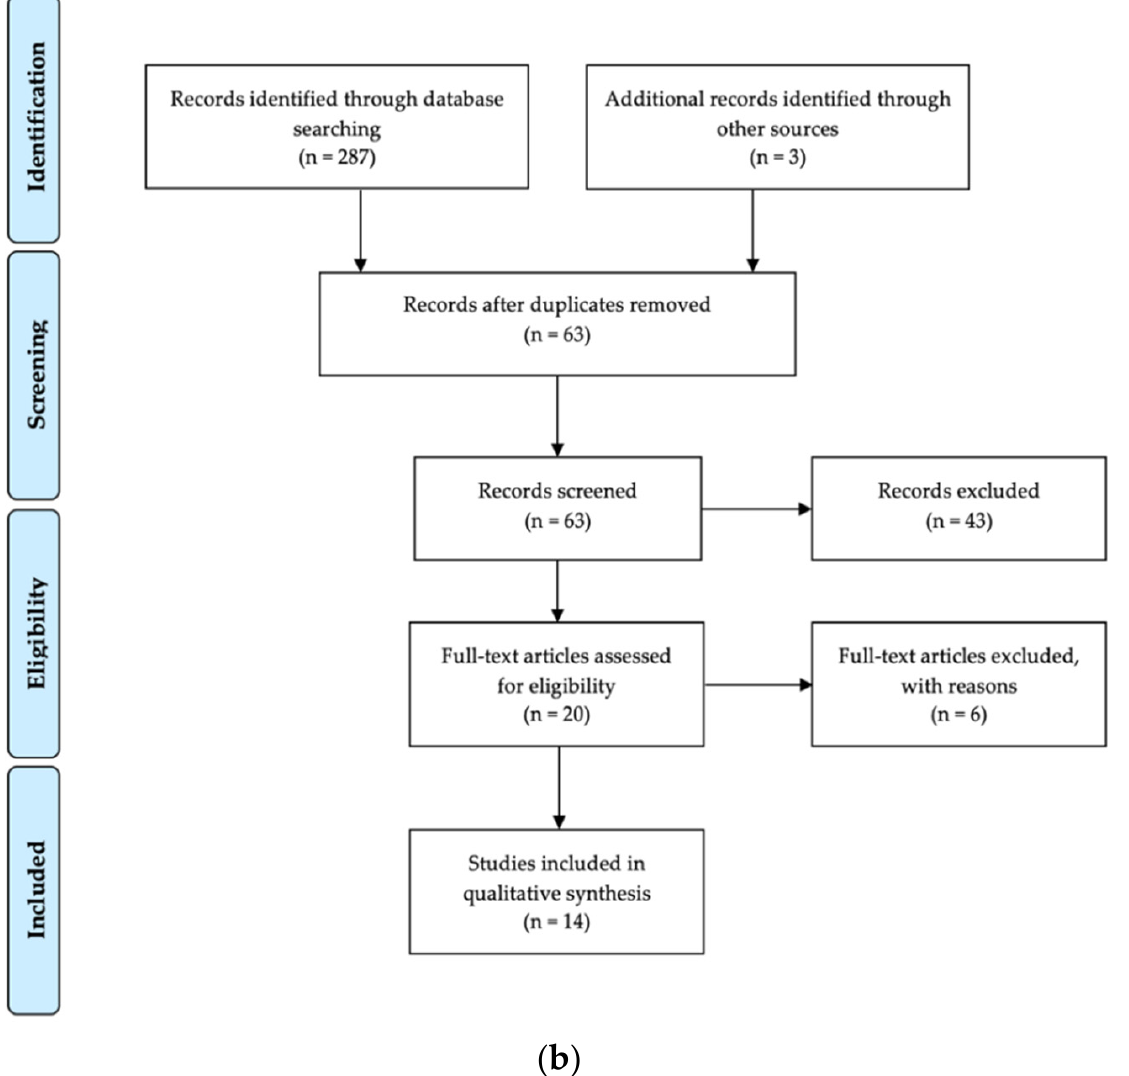
Figure 1. ( a ) PRISMA flow diagram showing the number of studies concerning salivary biomarkers for AD that were identified, screened, assessed for eligibility, excluded, and included in the systematic research. ( b ) PRISMA flow diagram showing the number of studies concerning salivary biomarkers for PD that were identified, screened, assessed for eligibility, excluded, and included in the systematic research. Table 1. Population characteristics in studies on salivary biomarkers for AD.